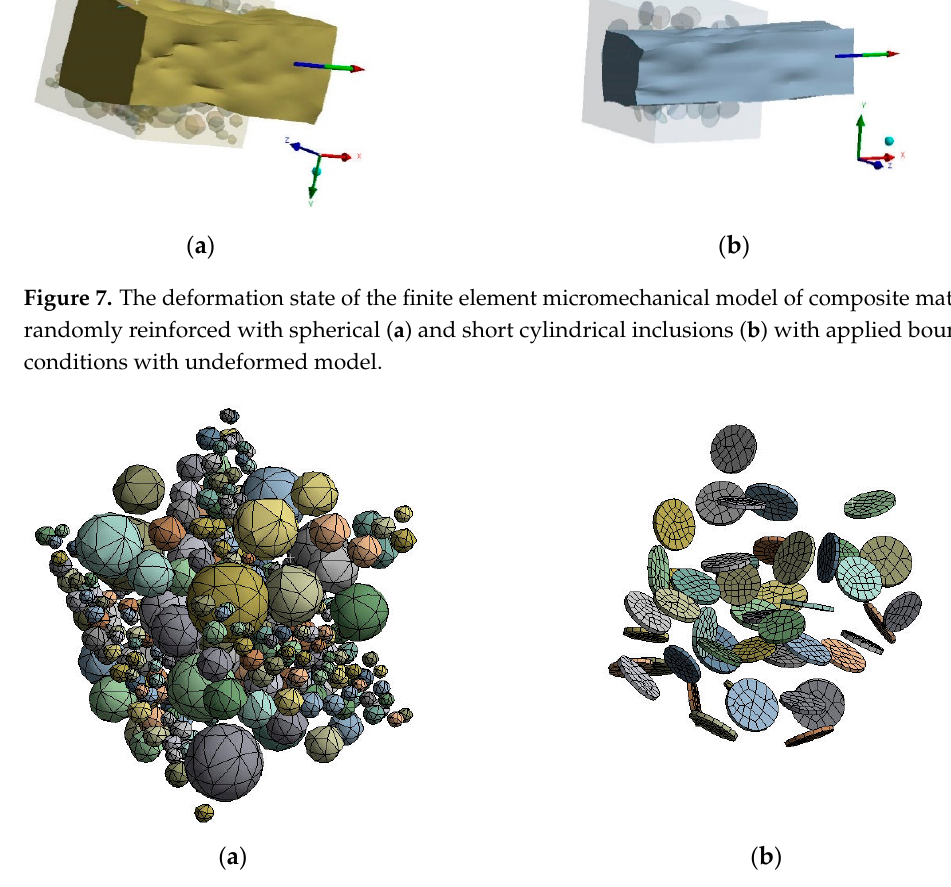
Figure 8. Finite element micromechanical models of fillers with spherical ( a ) and short cylindrical ( b ) inclusions.